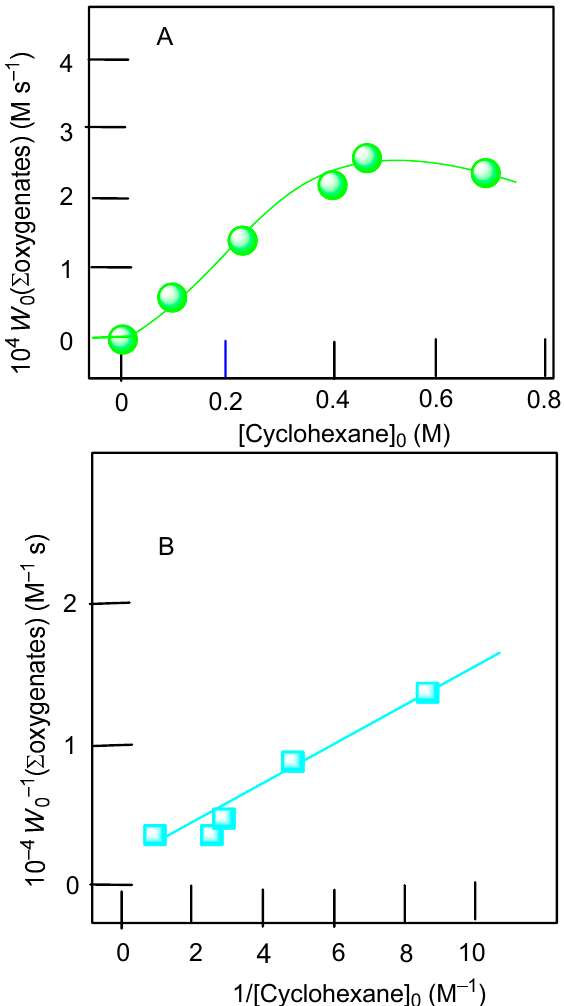
Figure 9. Dependence of the initial rate of oxygenate (sum cyclohexanol + cyclohexanone) formation W 0 for complex 2 on the initial concentration of cyclohexane is shown in graph A . Linearization of the curve from graph A in coordinates W 0–1 –1/[C 6 H 12 ] is presented in graph B . Concentrations of cyclohexanone and cyclohexanol were determined after reduction of the aliquots with solid PPh 3 .